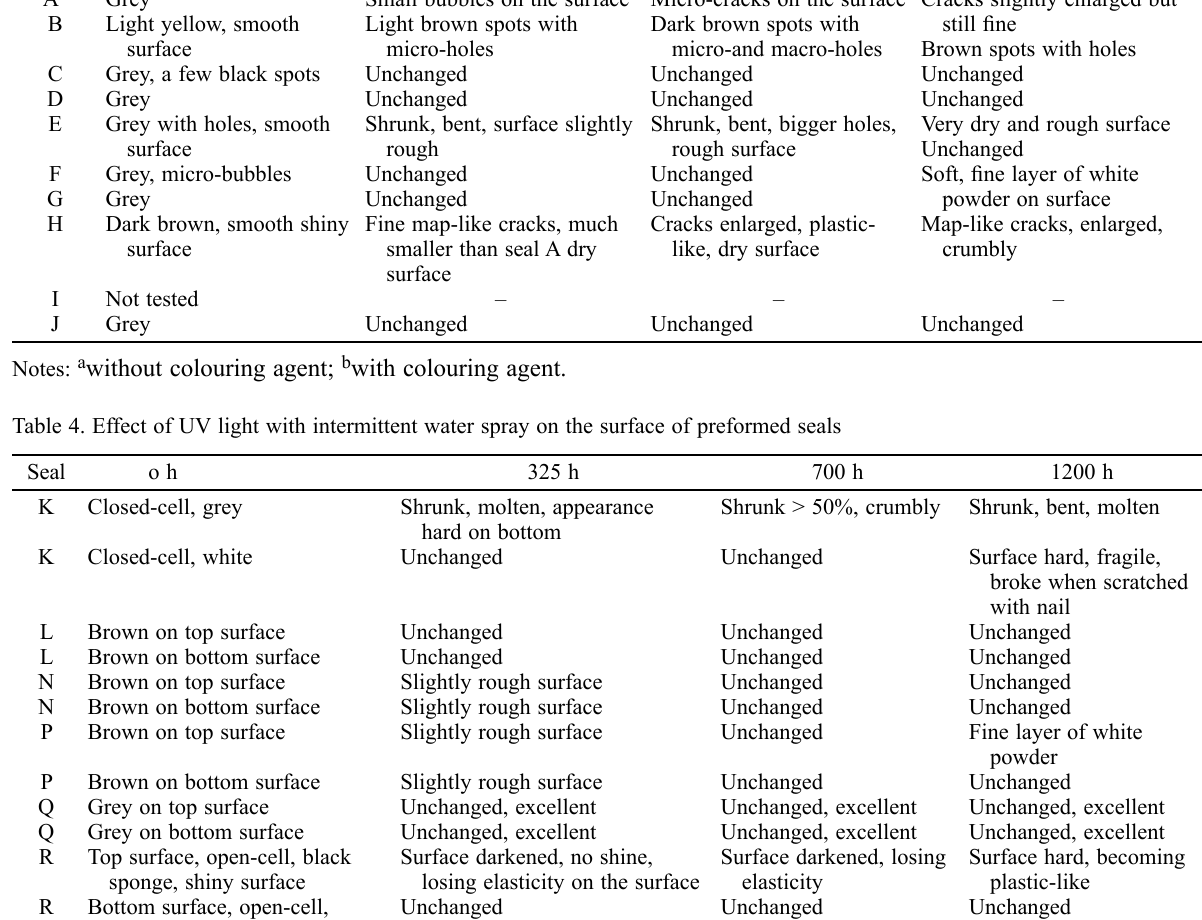
Dirty white, map-shaped cracks Small bubbles on the surface Light brown spots with